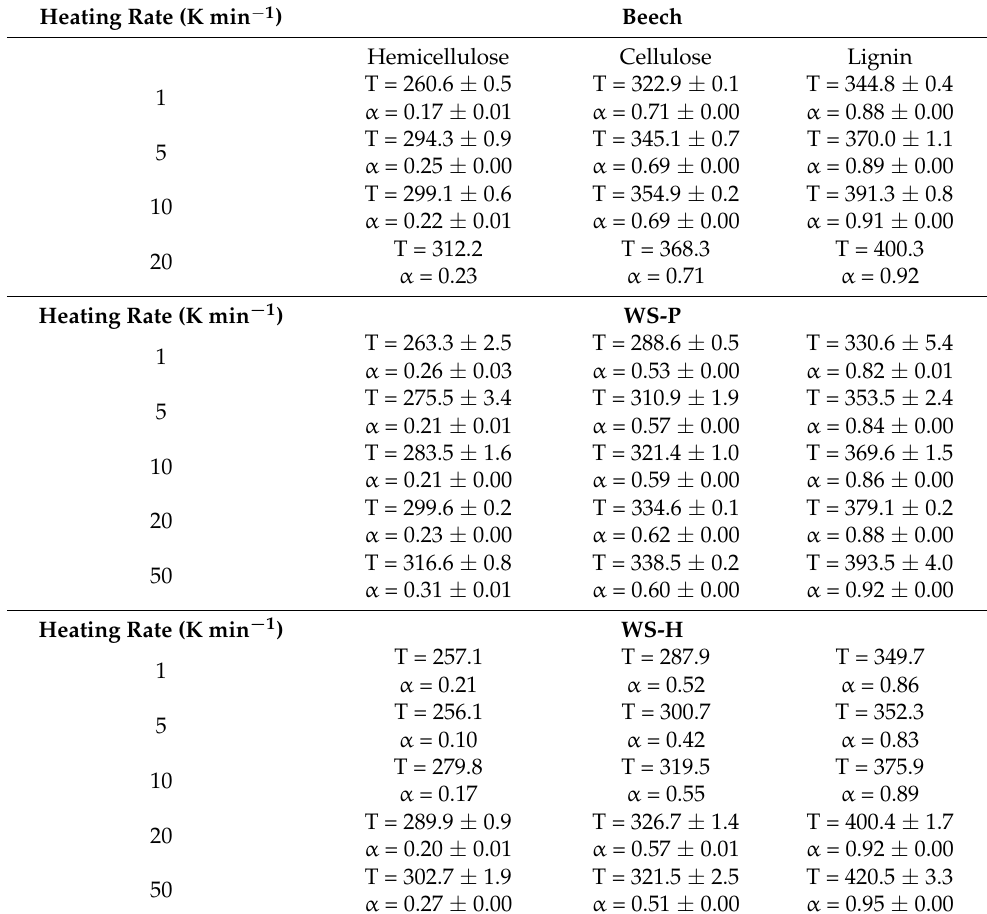
Table 5. Results of the second-derivative study. Temperature in ◦